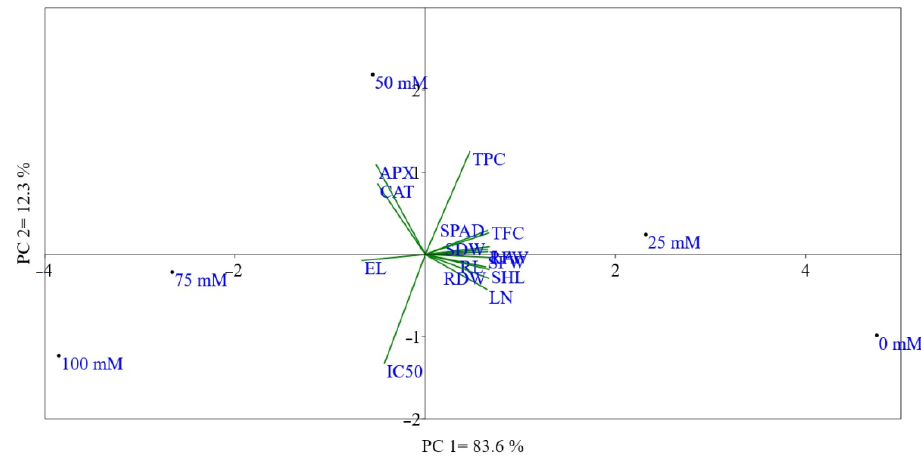
Figure 3. Biplot resulting from PCA procedure for all the variables measured in greenhouse condi- tions under different NaCl treatments (0, 25, 50, 75, and 100 mM). Leaf number (LA), leaf area (LA), root length (RL), root fresh weight (RFW), root dry weight (RDW), shoot length (SHL), shoot fresh weight (SFW), shoot dry weight (SDW), electrolyte leakage (EL), total phenol content (mg GAE/g) (TPC), total flavonoids (µg QE/g), catalase (µ Mol/g/min) (CAT), ascorbic peroxidase (µ Mol/g/min) (APX).